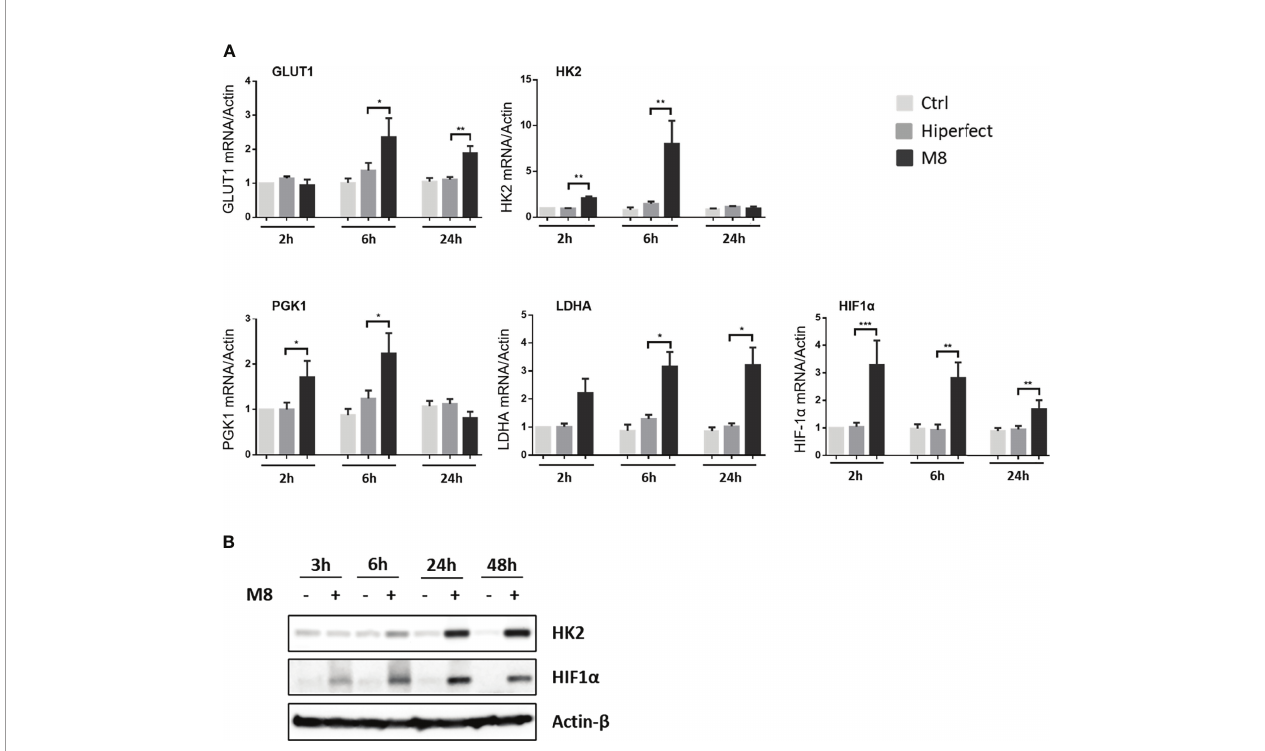
FIGURE 1 | Analysisof metabolic enzyme expressionsduringmonocyte-deriveddendriticcells (MoDCs)maturation byM8. (A) CD14+ monocytes isolated fromfreshly collected blood of healthy donorswere differentiated in the presence ofGM-CSF(Granulocyte-macrophage colony-stimulatingfactor)and IL-4 for 5 daysand stimulated with 50 ng/ml of M8for 2 – 24h.RNA was extracted and usedfor RT-PCR analyses ofglycolytic molecules (GLUT1, HK2, PGK1, LDHA, and HIF1 a ).RNA expression was normalized on b -actin,and results represent fold changes compared with CTRL, set as 1. Data are representative offourindependent experiments ( n = 4). (B) Immunoblot analyses of HK2and HIF-1 a in MoDCs treated or not for the indicatedhours by M8 (50 ng/ml),protein amount was normalizedonGAPDHprotein expression.